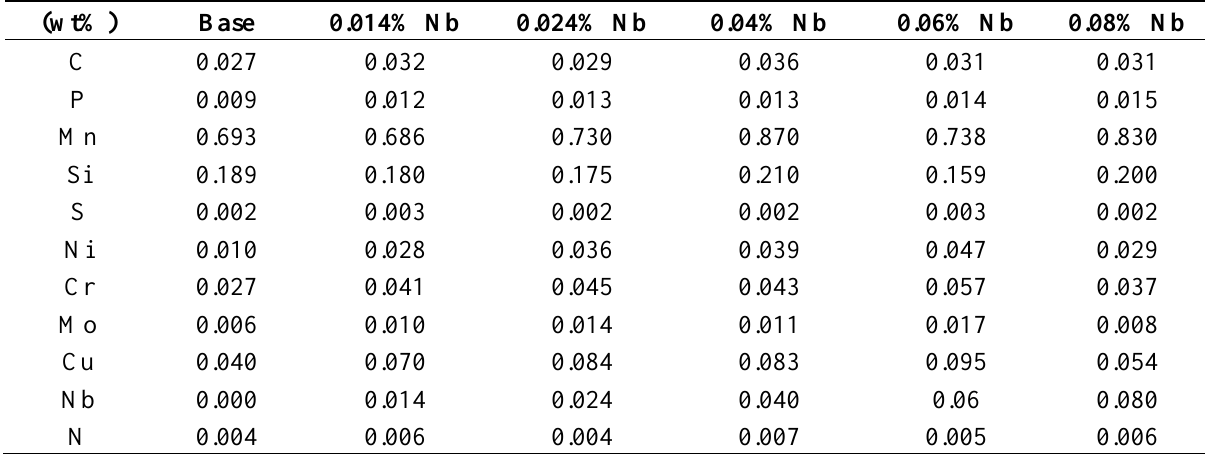
Table 1. Chemical composition of the tested CASTRIP ultra-thin cast strip (UCS)